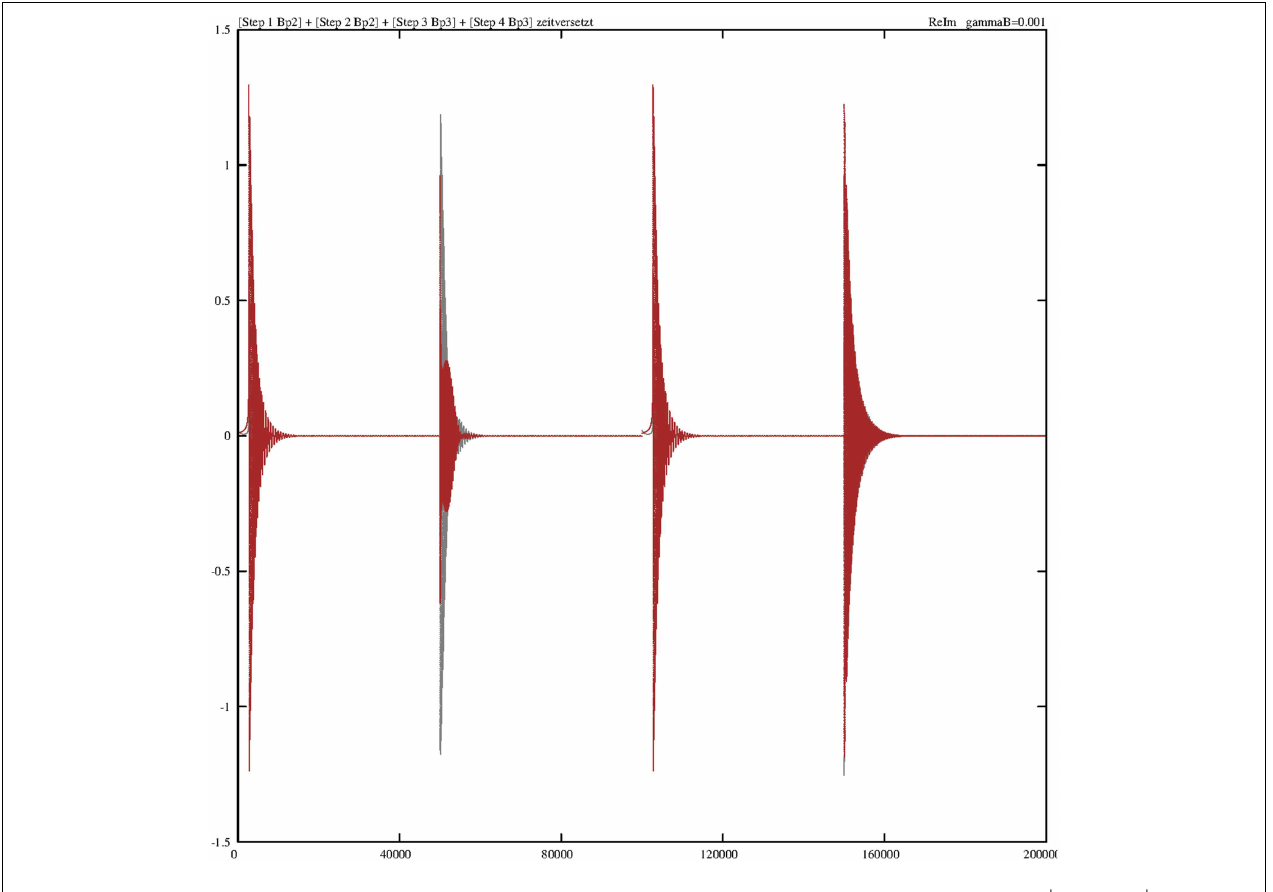
. The , Bp 3 B † p B † p 3 2 = = 0 . 001 . The coupling constants are =